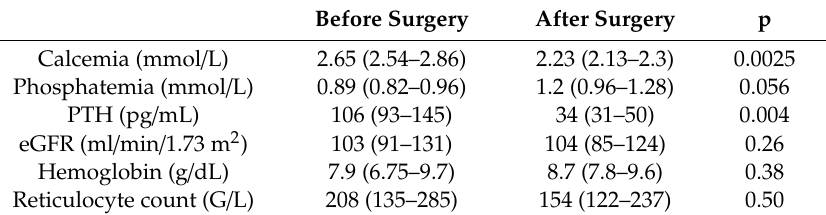
Laboratory features of 14 SCD patients with primary hyperparathyroidism and surgical management. Before Surgery After